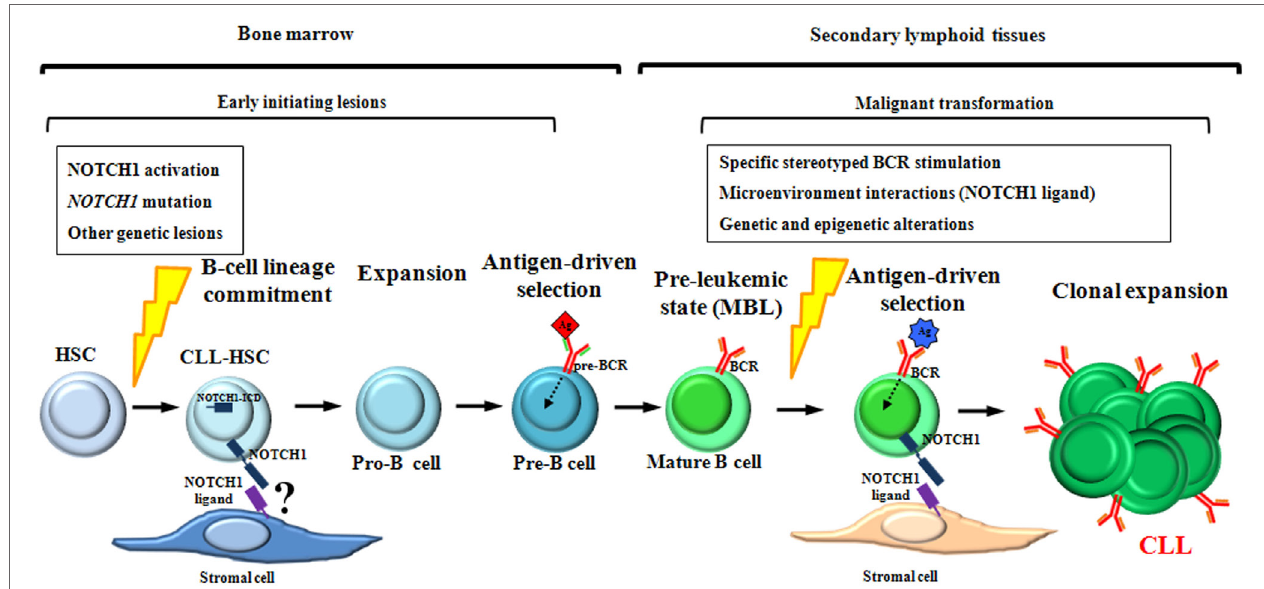
FigURe 6 | Schematic representation of NOTCH1 involvement during chronic lymphocytic leukemia (CLL) development. NOTCH1 activation and mutation are early oncogenic events acquired within hematopoietic stem cells (HSCs) and maintained in their hematopoietic progeny. As suggested by xenograft models, CLL-HSCs are skewed toward B-cell differentiation giving rise to premalignant B cells that resemble human MBL, the pre-leukemic state of CLL. We hypothesize that NOTCH1 alterations, together with other oncogenic events, contribute to the generation of pre-leukemic mature B cells by favoring the expansion of pro-B cells and by cooperating with pre-BCR signaling during the antigen-driven selection of pre-B cells. In lymphoid tissues, antigenic stimulation of specific stereotyped BCRs, in combination with NOTCH1-related microenvironment interactions and additional genetic lesions, might have a role in the transformation process of pre-leukemic mature B cells into